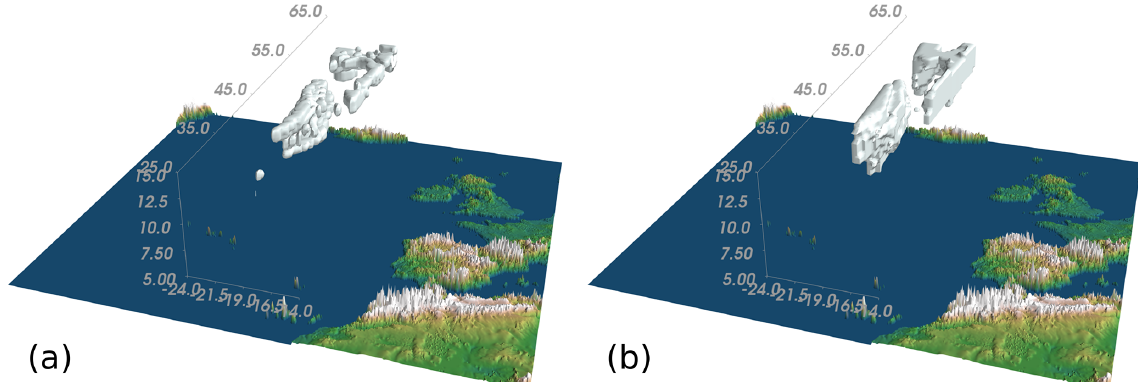
Figure 10. The true (a) and derived (b) cloud structure using the convex hull CI algorithm. A white contour surface is shown for 10 − 3 km − 1 in the measurement track of the IRLS. The vertical dimension is stretched by a factor of roughly 100. Due to the employed cylindrical projection, the measurements expand towards the